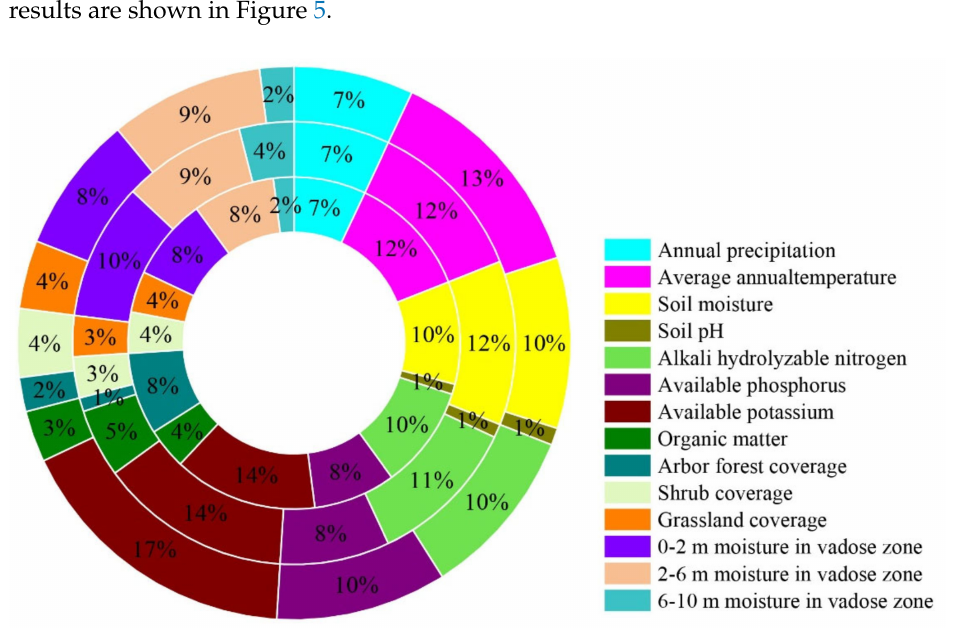
Figure 5. The evaluation factor ring weight